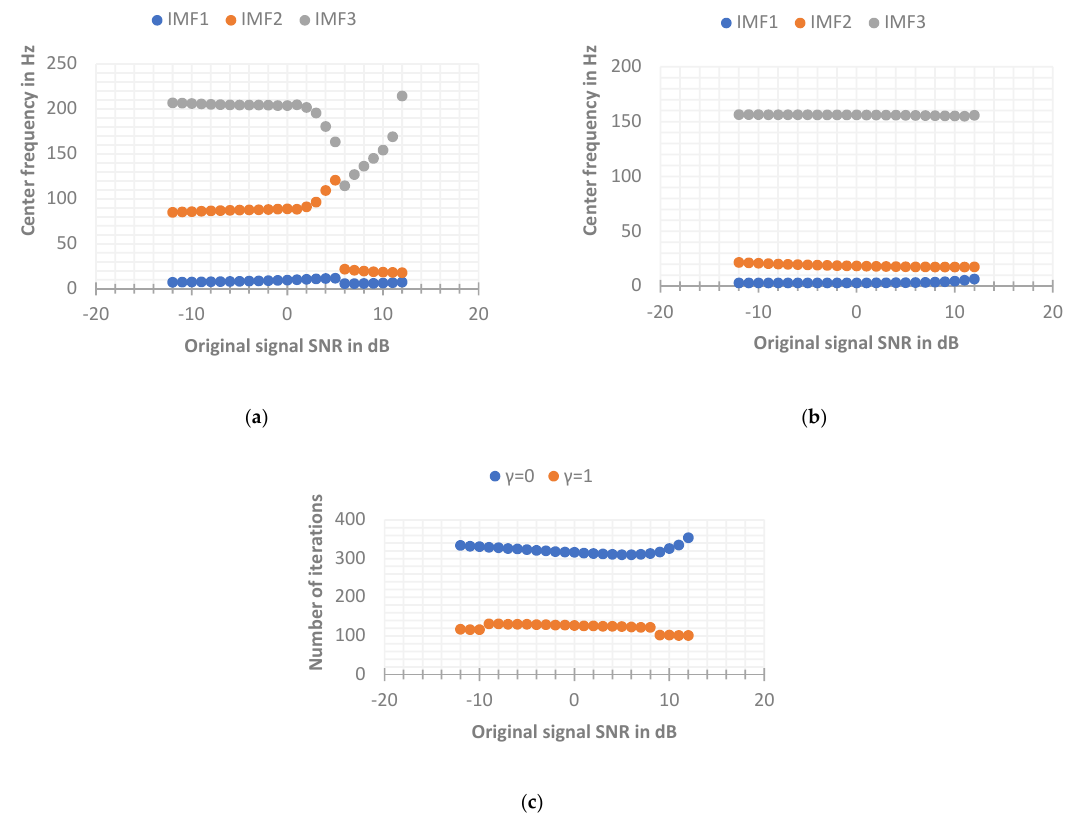
Figure 9. The final convergence center frequency and convergence times of the simulated signal with the initial center frequency set to fixed. ( a ) The components at γ = 1 eventually converge to the central frequency. ( b ) The components at γ = 0 eventually converge to the central frequency. ( c ) The number of iterations with different values of γ